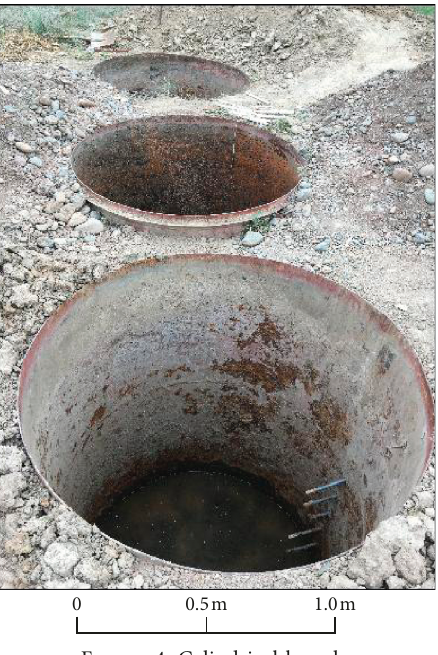
Figure 4: Cylindrical